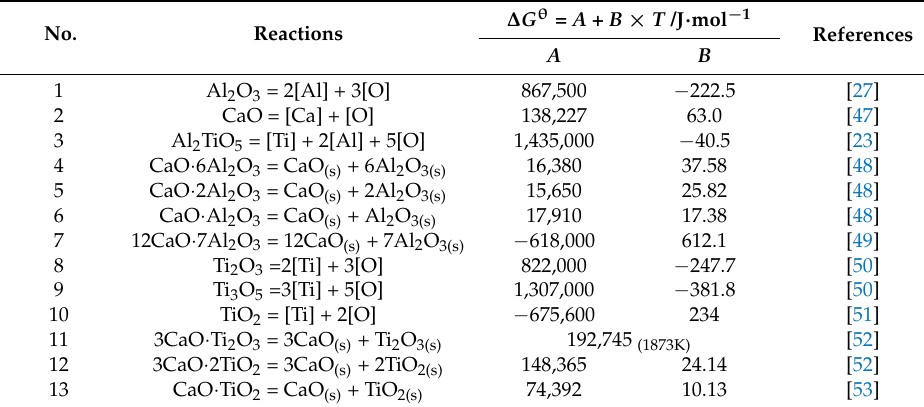
Table 3. Standard Gibbs energies of inclusions formation.